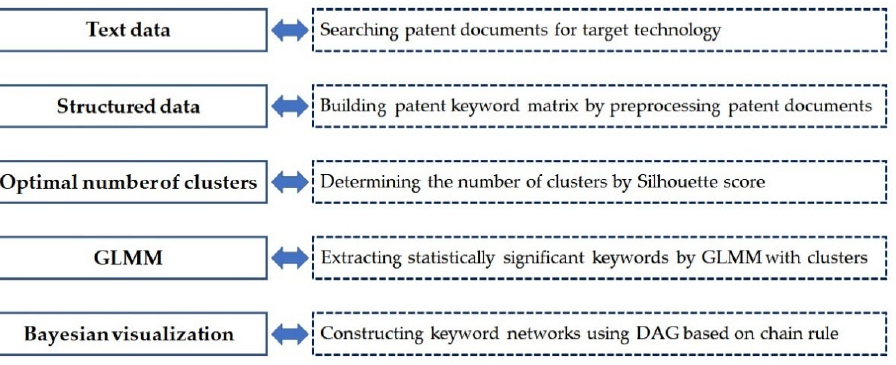
Figure 4. Procedures of the proposed methods.